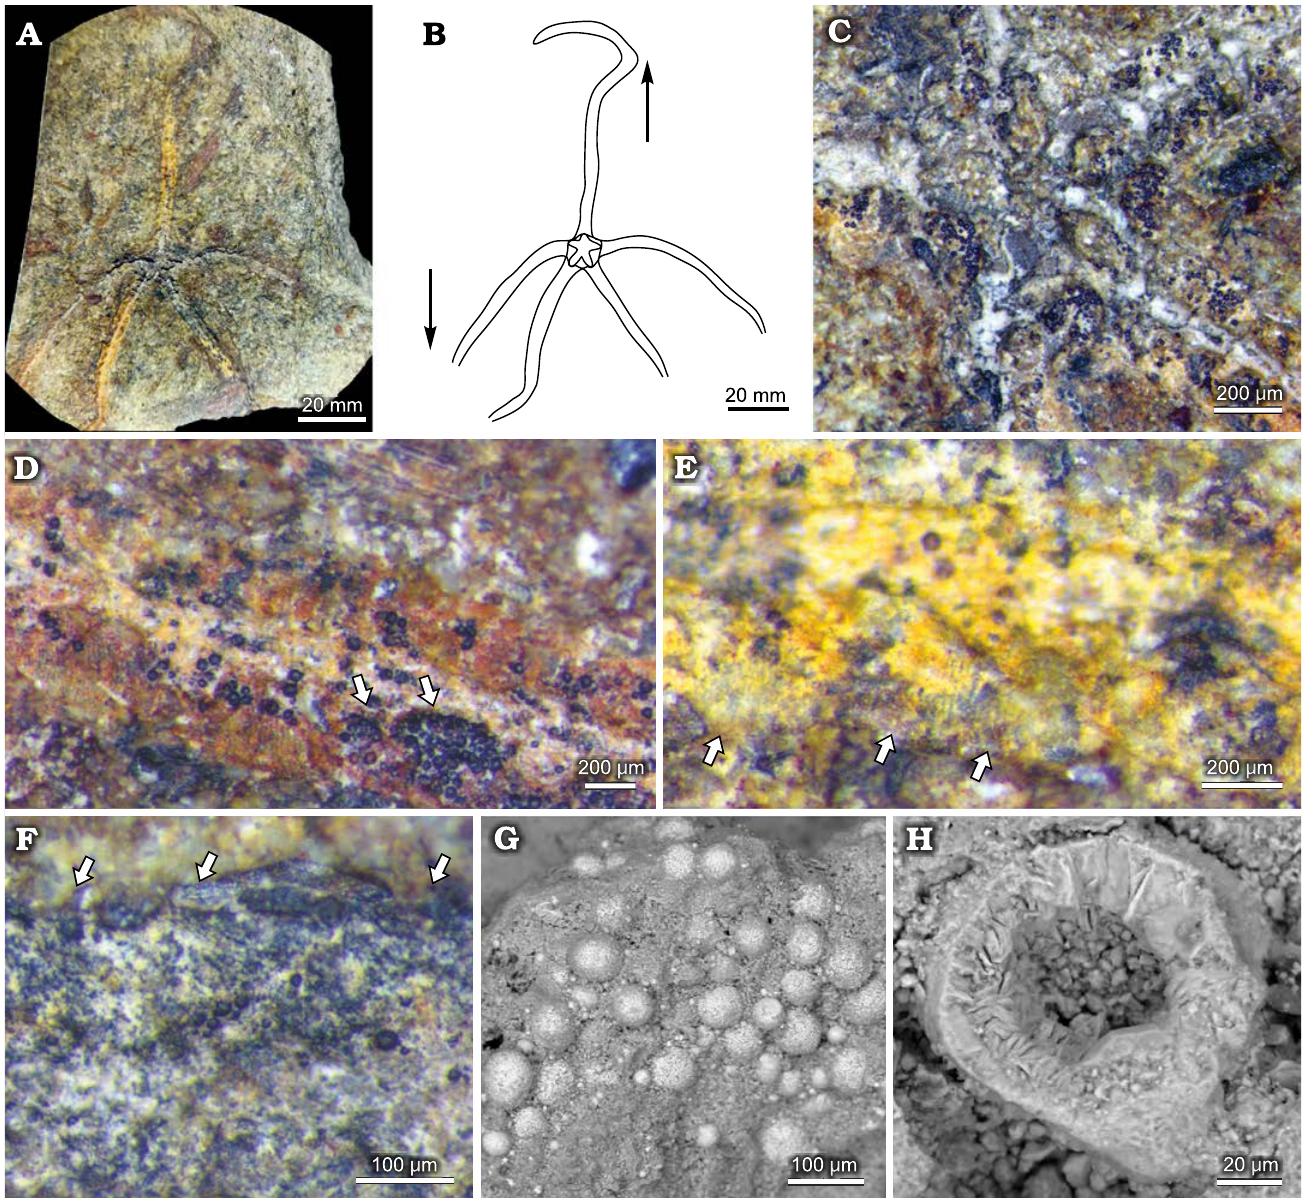
Fig. 4. Ophioleucid ophiuroid Sinosura sp. (MOZ-PI-5930) from the lower Pliensbachian of Sierra Chacaicó Formation, Arroyo Lapa locality, Neuquén, Argentina. A . General view of the studied specimen. B . Diagram of ophiuroid burial position, note that the unpaired arm is oriented in the opposite direc- tion of the other four arms. C . Detail of the central disc. D . Close view of the unpaired arm, arrows showing pyrite framboids. E . Close view of a paired arm, arrows showing limonite covering striated lateral ossicles. F . Unpaired arm close view, arrows showing spines. G . SEM caption of arm lateral ossicle, stereom structure is obscured by the presence of pyrite framboid aggregation. H . Radiolarian test preserved near the ophiuroid